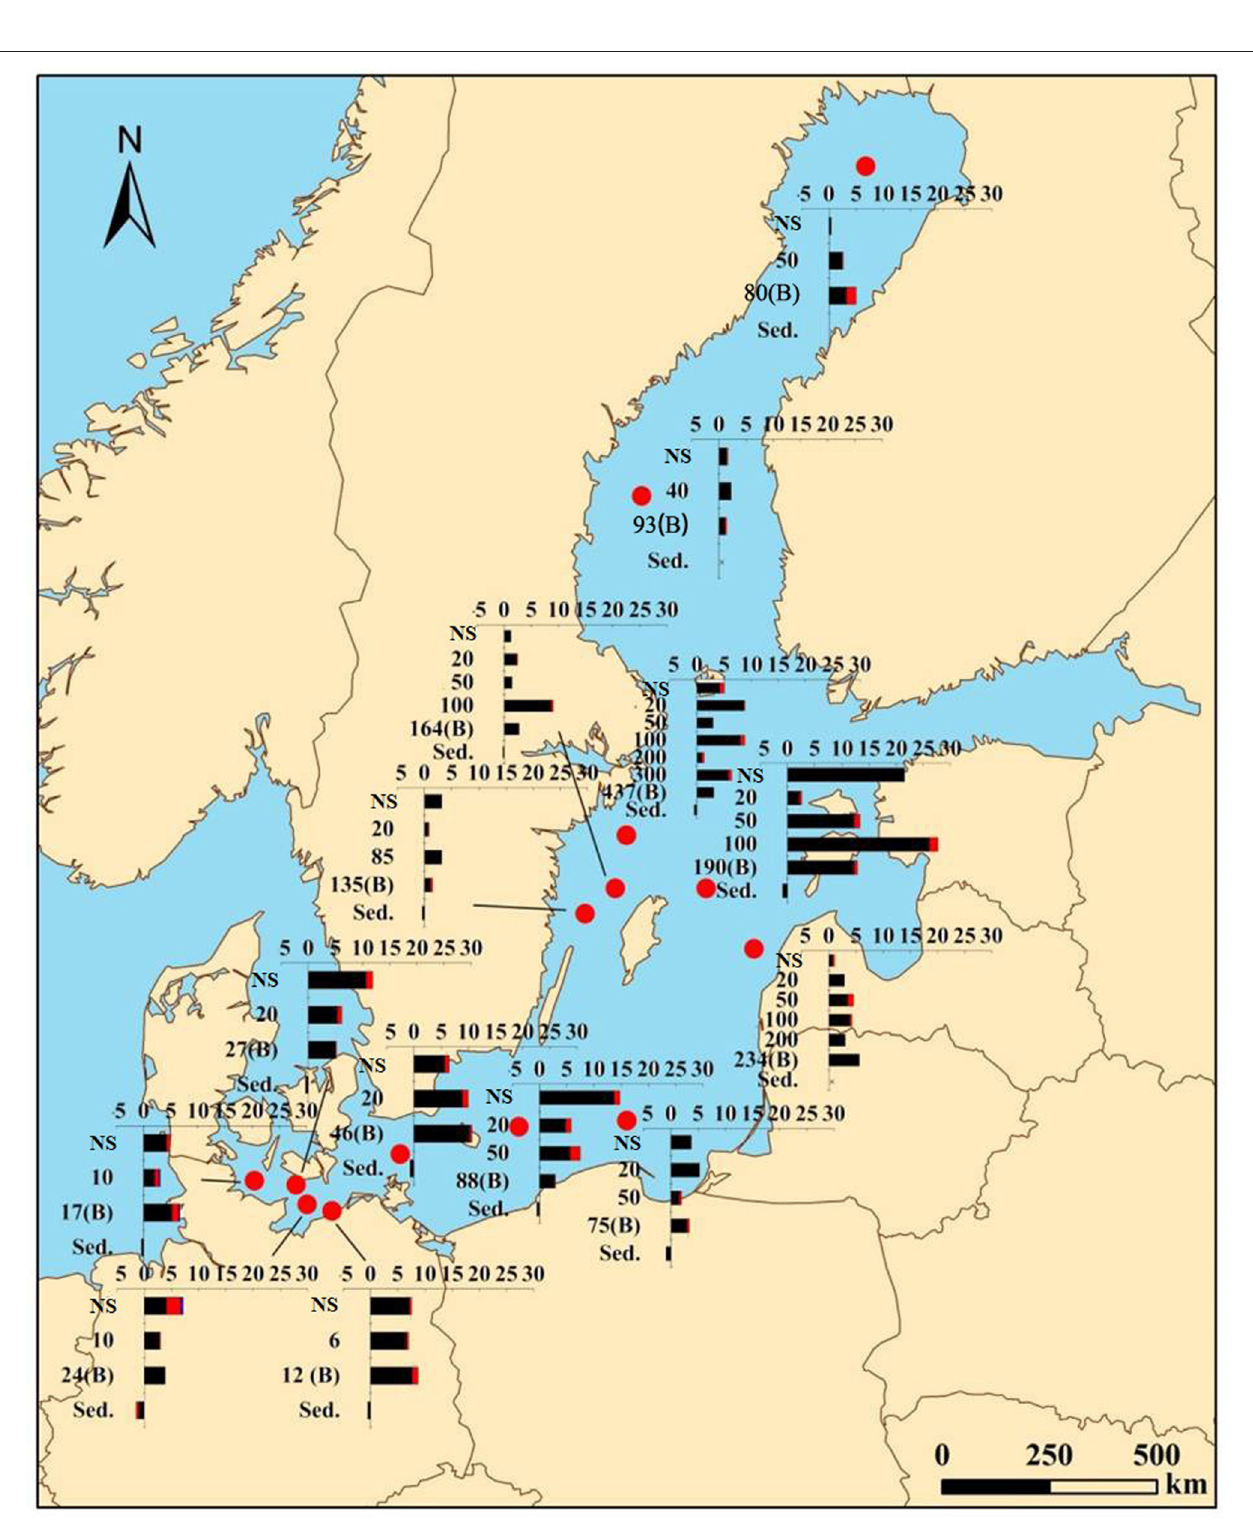
FIGURE 2 | Distribution of different microplastic types in the water and sediments in the Baltic Sea. The unit of the abundance of microplastics in the water column and sediments are items L − 1 and items g − 1 d.w.; “NS,” near the surface; “B,” near-bottom layer; “Sed.,” sediment; the Y -axis represents sampling depth (m); the X -axis represents the abundance of